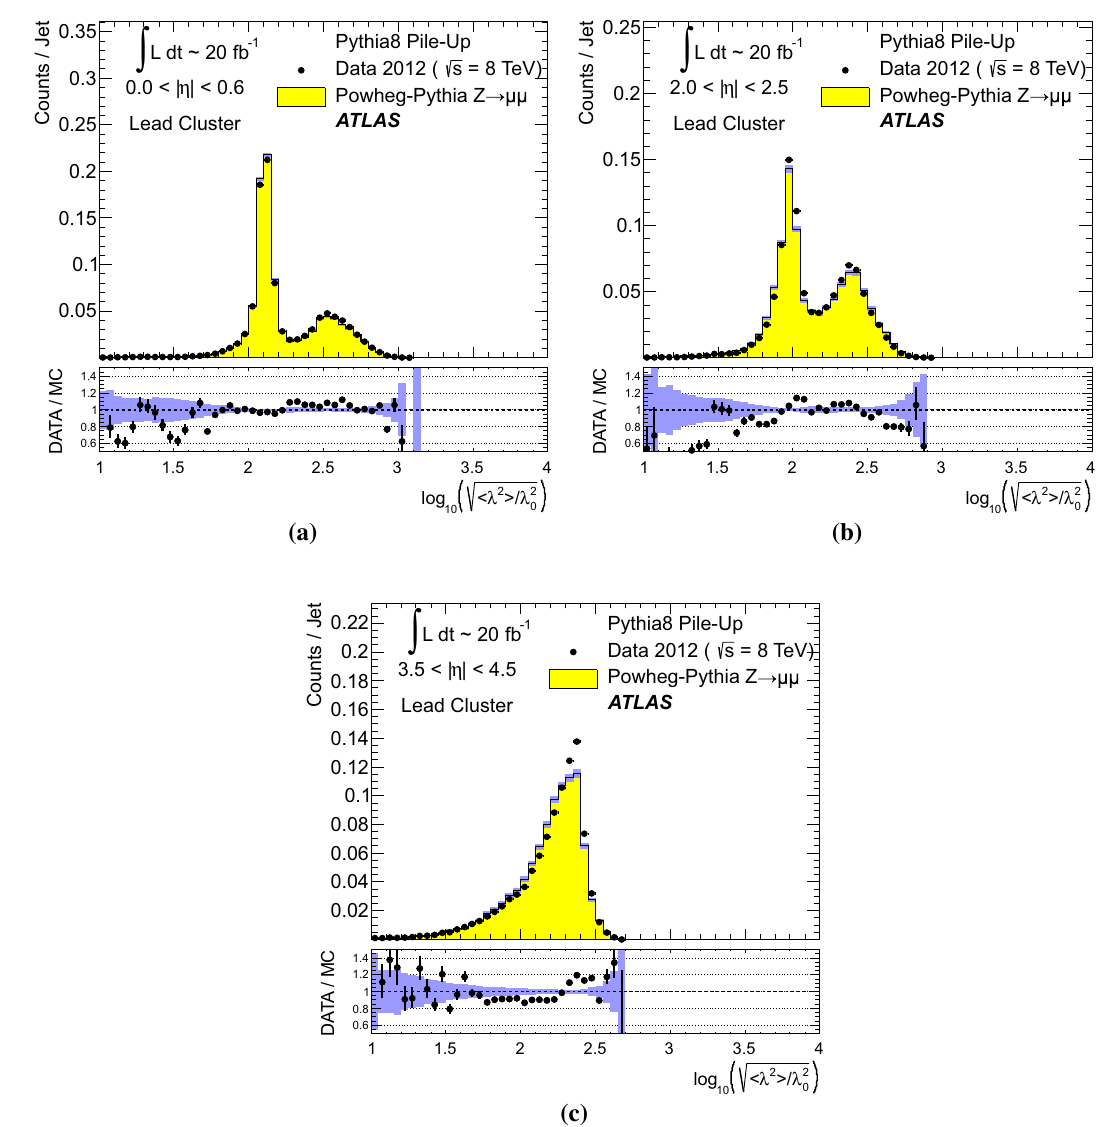
Fig. 42 Thelengthoftheleadingtopo-cluster,measuredintermsofthe (2 . 0 < | η | < 2 . 5), and the c forward detector region (3 . 5 < | η | < 4 . 5). longitudinal spread (second moment) (cid:7) λ 2 (cid:8) of the cell coordinates along The normalisation of the longitudinal spread is given by λ 0 = (cid:21) (cid:7) λ 2 (cid:8) /λ 2 the principal cluster axis by , in anti- k t jets reconstructed with 0 < 40GeV in Z → μμ events in R = 0 . 4 and 30GeV < p LCW + JES T , jet 2012 data and MC simulations with fully simulated pile-up. Distribu- tions are shown for jets in the a central ( | η | < 0 . 6), the b end-cap